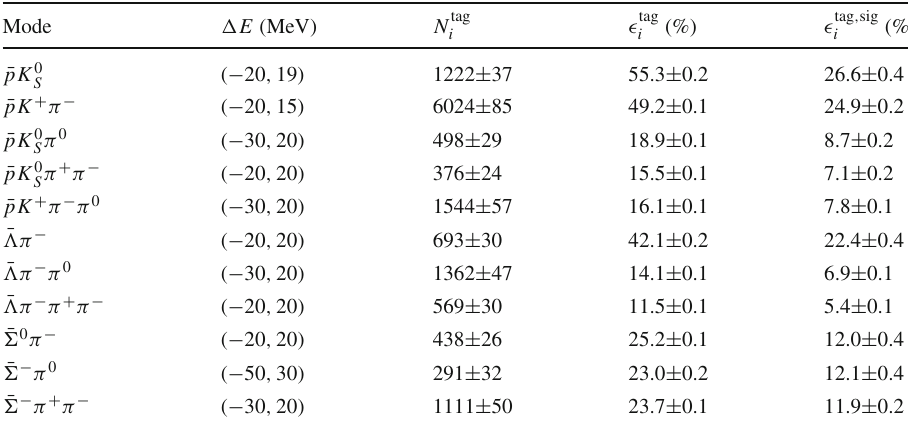
Table 2 Requirements on (cid:9) E